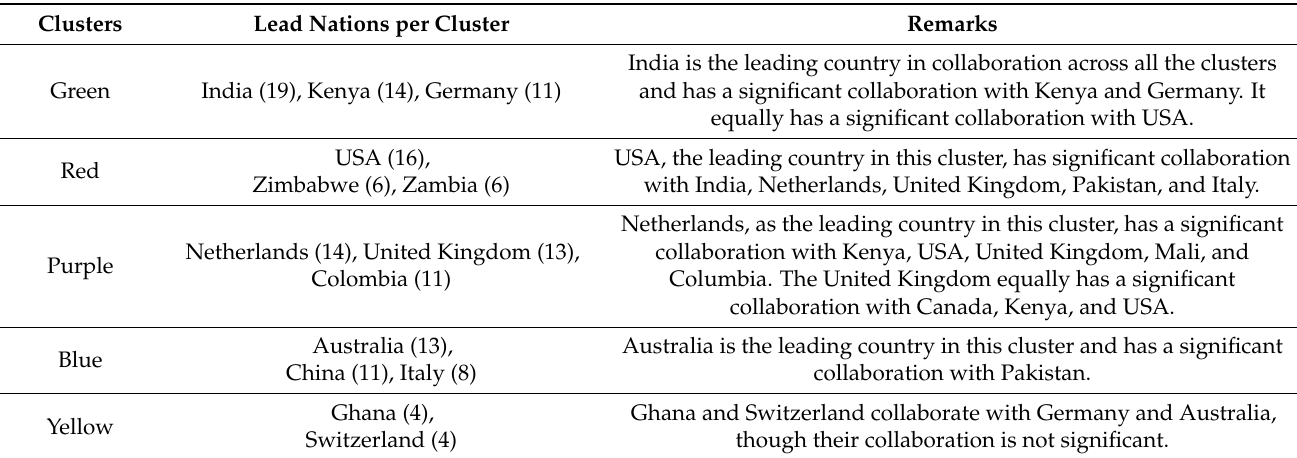
Table 8. Cluster of institution collaborations around the globe within the period 2009–2022.